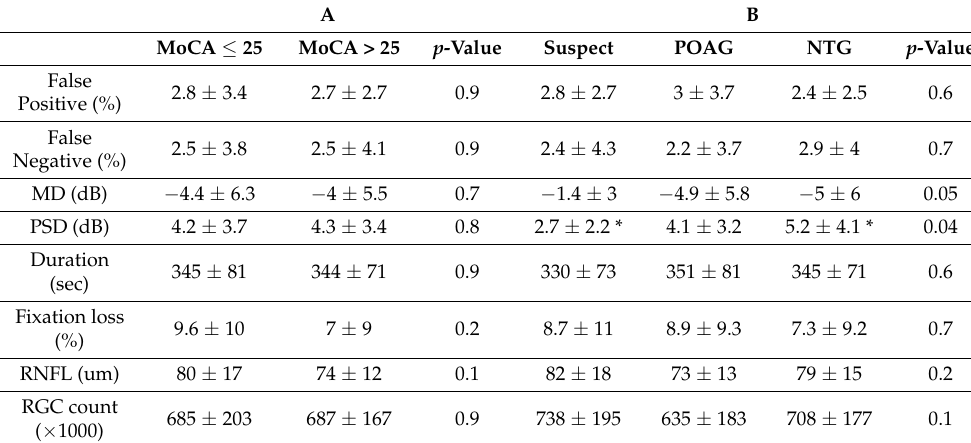
Table 2. Distribution of visual field and structure–function characteristics. Assessed based on (A) MoCA scores and (B) glaucoma